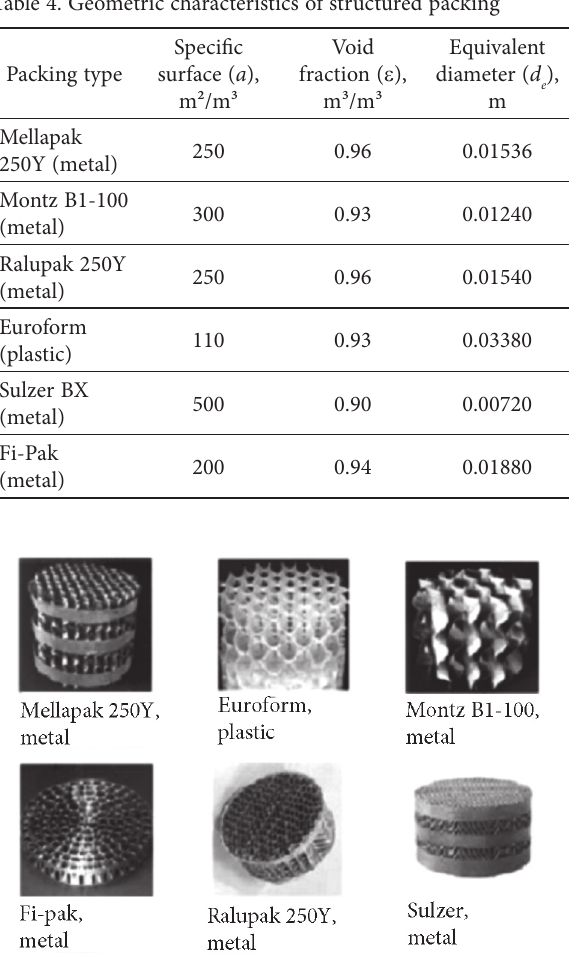
Fig. 5. Typical forms of the most commonly used industrial structured